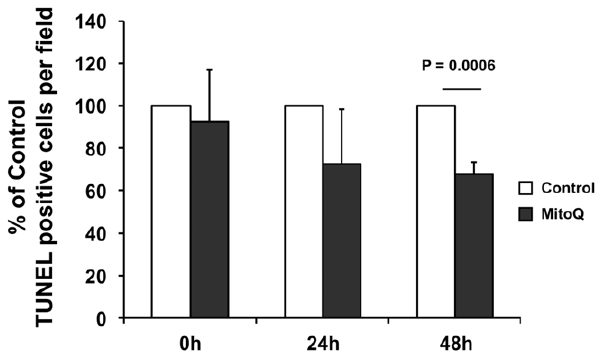
Figure 4. MitoQ blocks cold storage induced renal cell death. TUNEL positive cells were counted in 8 different fields (200X), and the average was reported. The graph shows percentage change of TUNEL positive cells after MitoQ treatment when compared to respective contra lateral control kidneys. Error bar indicates Mean 6 S.E.M. (n=5 for both groups). MitoQ significantly reduced TUNEL positive nuclei after 48 h of cold storage (P=0.0006).